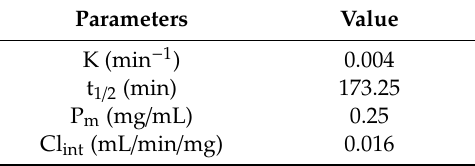
Table 7. Oxidation metabolism parameters of 32d in human liver microsomes ( n =